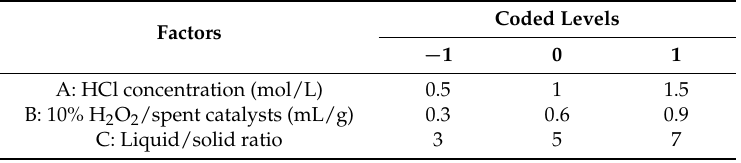
Table 4. Experimental design for Pt leaching, and their coded and actual levels.